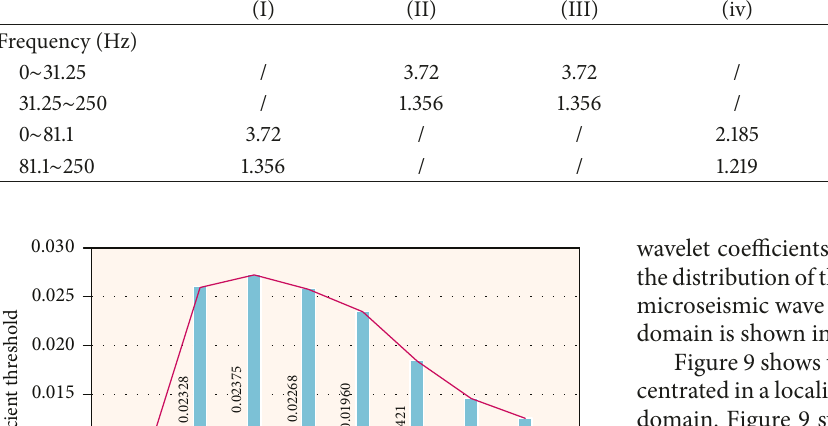
Table 1: Necessary wavelet packet coefficient thresholds restricted by the frequency threshold in a specific time window. Threshold